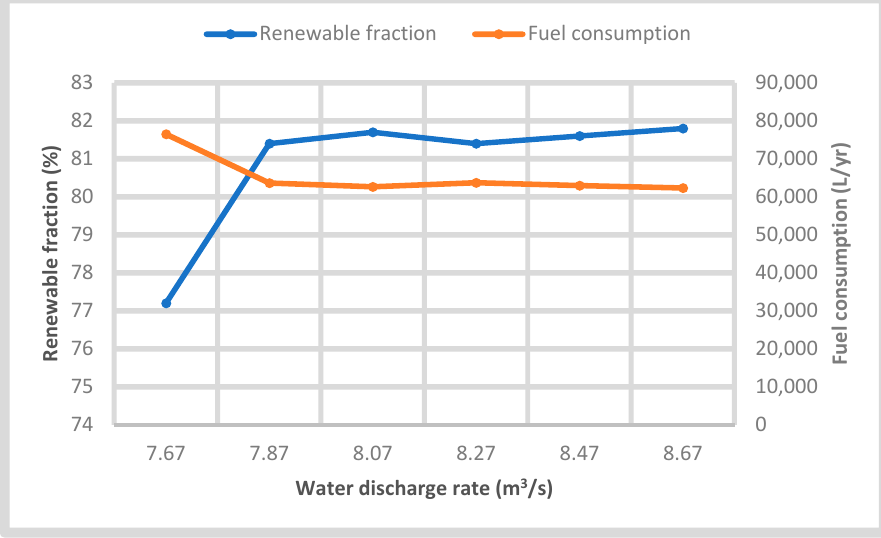
Figure 16. Effect of WSF on the renewable fraction and annual fuel consumption.